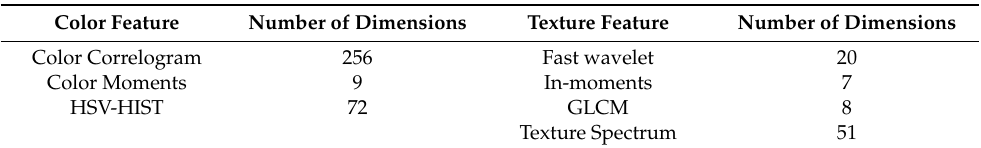
Table 2. Description of the feature vector.